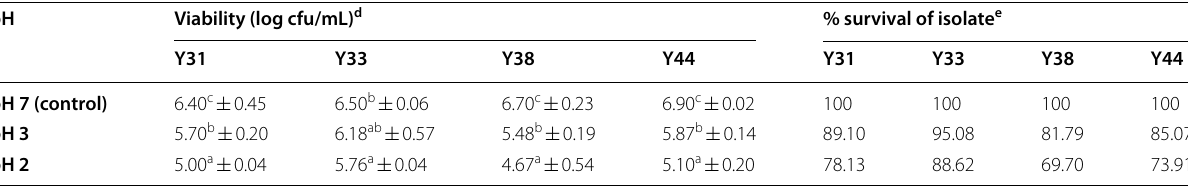
Table 2 Acid tolerance (log cfu/ mL) of yeast isolates after 3 h of incubation